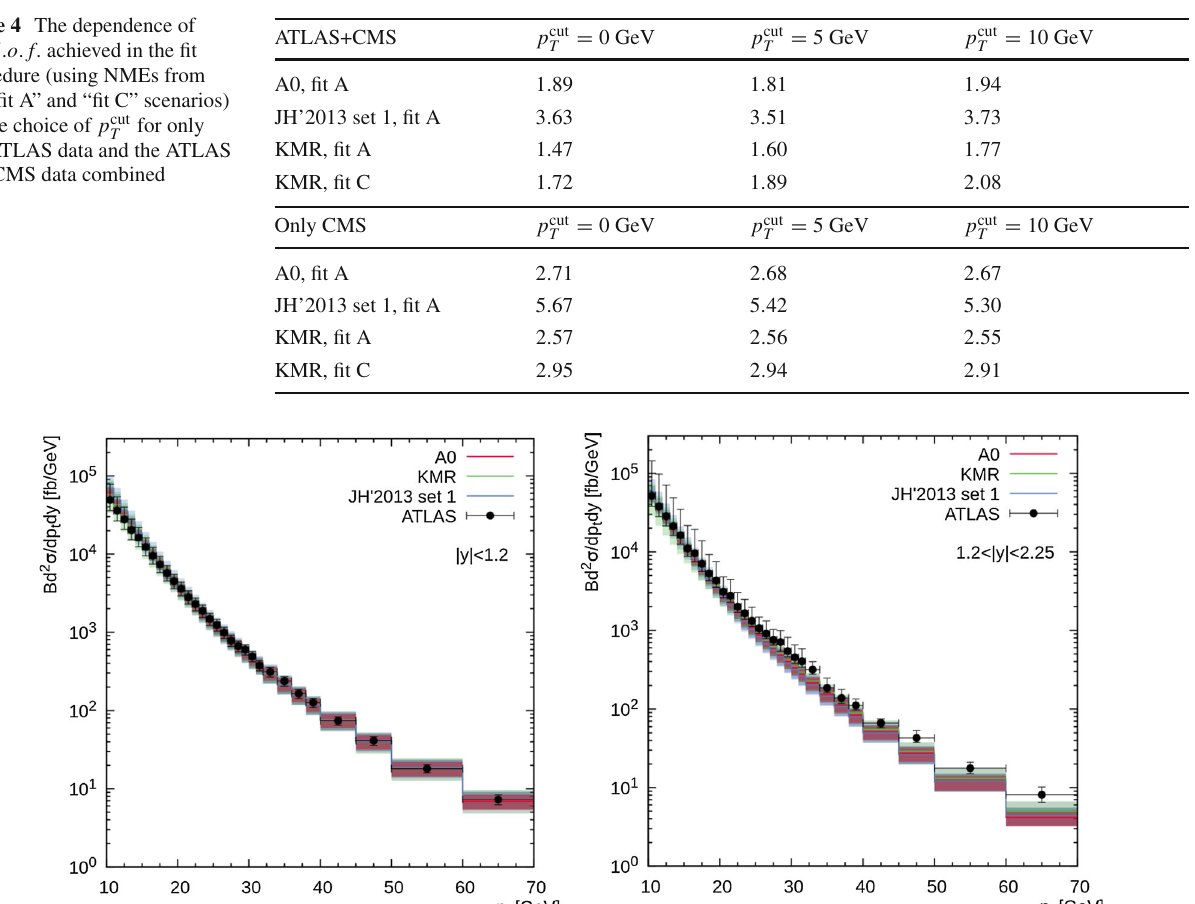
Fig. 1 Transverse momentum distribution of the inclusive ϒ( 1 S ) pro- √ s = 7 TeV in the different rapidity regions. The duction calculated at red, green and blue histograms correspond to the predictions obtained